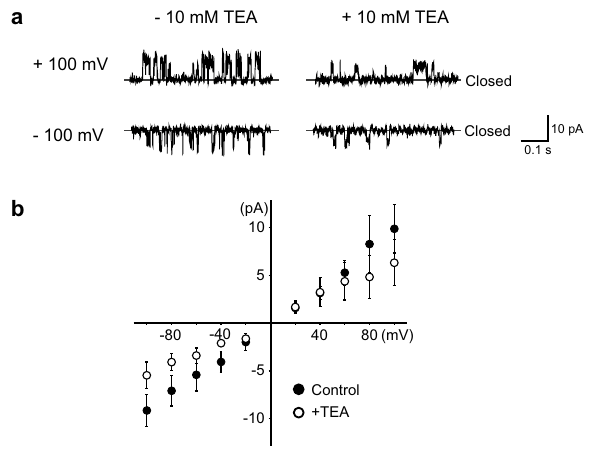
Figure 6. Analysis of effects of tetraethylammonium (TEA) on the activity of wild-type KcsA channels (KcsA(WT)) using the automated measurement system. (a) Representative current traces of KcsA(WT) channel measured in the bilayer membrane consisting of POPE–POPG and n -decane in the indicated conditions. The single-channel currents were smaller in the presence of TEA than in its absence. (b) Current–voltage relationship for the KcsA(WT) KcsA channel (n = 7) in the absence (Control) and presence (+ TEA) of 10 mM TEA (n = 5). POPE 1-palmitoyl-2-oleoyl-sn-glycero-3-phosphoethanolamine; POPG 1-palmitoyl-2-oleoyl-sn- glycero-3-[phospho-rac-(1-glycerol)]; POPE–POPG lipid solution consisting of 18 mg/ml POPE and 6 mg/ml